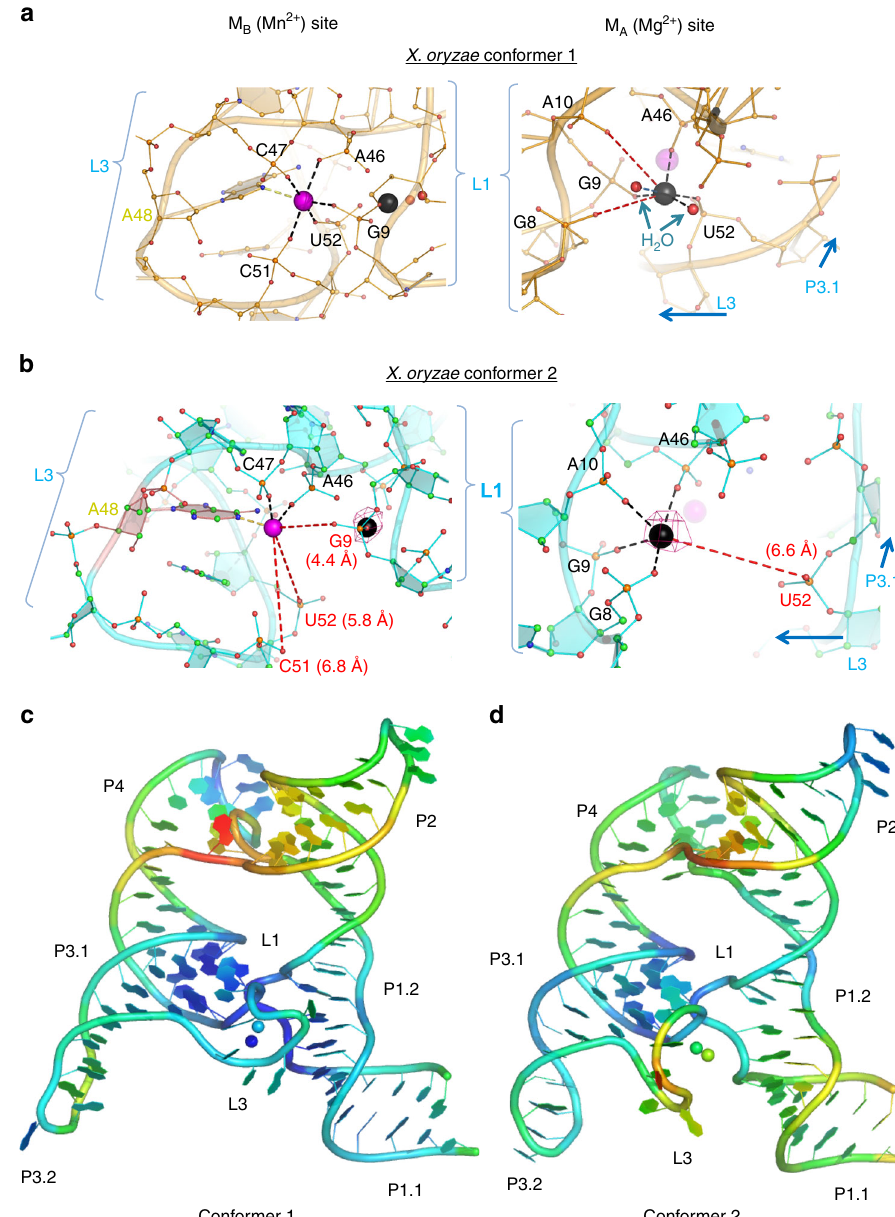
Fig. 2 Conformational differences in the metal ion binding sites and B-factors in the structures. Close-up view of the M A,Mg (black) and M B,Mn (purple) metal ion binding sites of a Conformer 1 and b Conformer 2 showing different contacts with surrounding L1 and L3 residues. Waters are shown as red spheres. The lost metal ion contacts are shown as red dashed lines with their distances. The anomalous difference map at 4 σ (magenta mesh) shows that Sr 2 + is not observed in Conformer 1 and weakly occupies the M A,Mg site but not the M B,Mn site in Conformer 2. The Llac-Mn structure is shown in Supplemental Fig. 5 in the same orientation for comparison. Overall X. oryzae Conformer 1 ( c ) and Conformer 2 ( d ) structures, colored by individual atomic temperature B-factors (range: 38 – 135 Å 2 for Conformer 1, 44 – 170 Å 2 for Conformer 2). Notice both are well-structured in L1 and in P3 around the binding site. However, Conformer 1 is much more tightly structured in L3 than is Conformer 2. Also, the metal ions in Conformer 1 are somewhat less variable. In both molecules, there is fl exibility around the